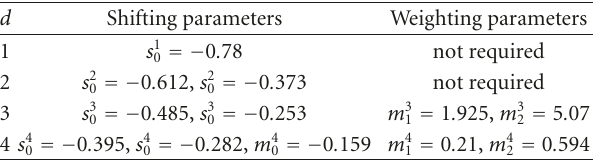
Table 1: Shifting and weighting parameters d Shifting parameters Weighting